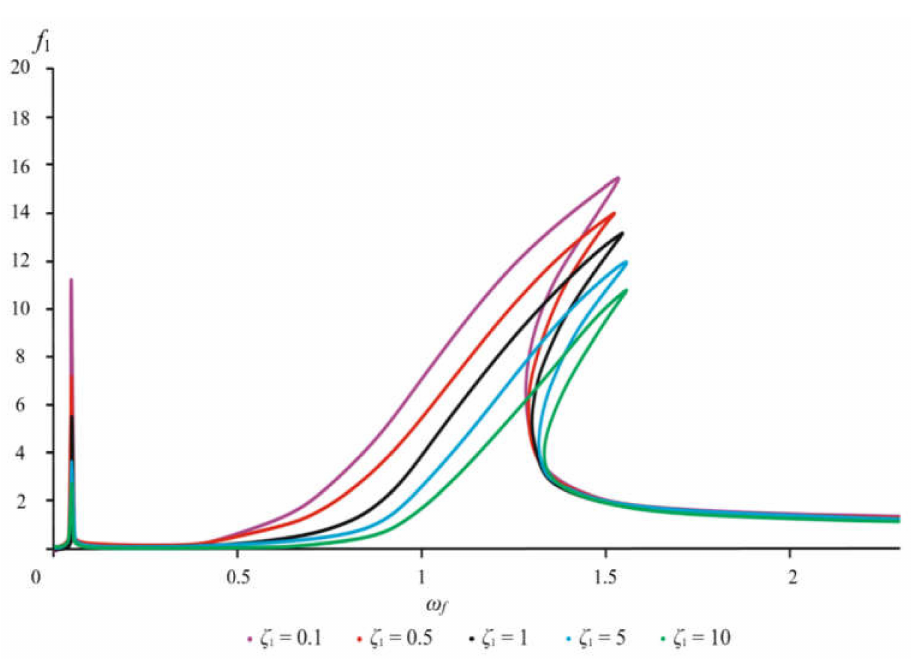
Figure 7. The amplitude-frequency characteristic of the rotor at different values of damping